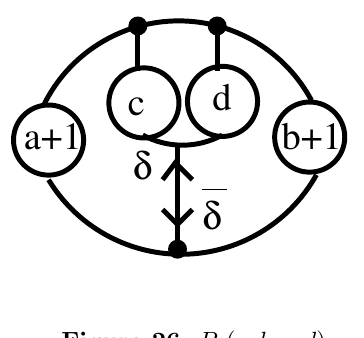
Figure 26 . P 4 ( a; b ; c; d ).